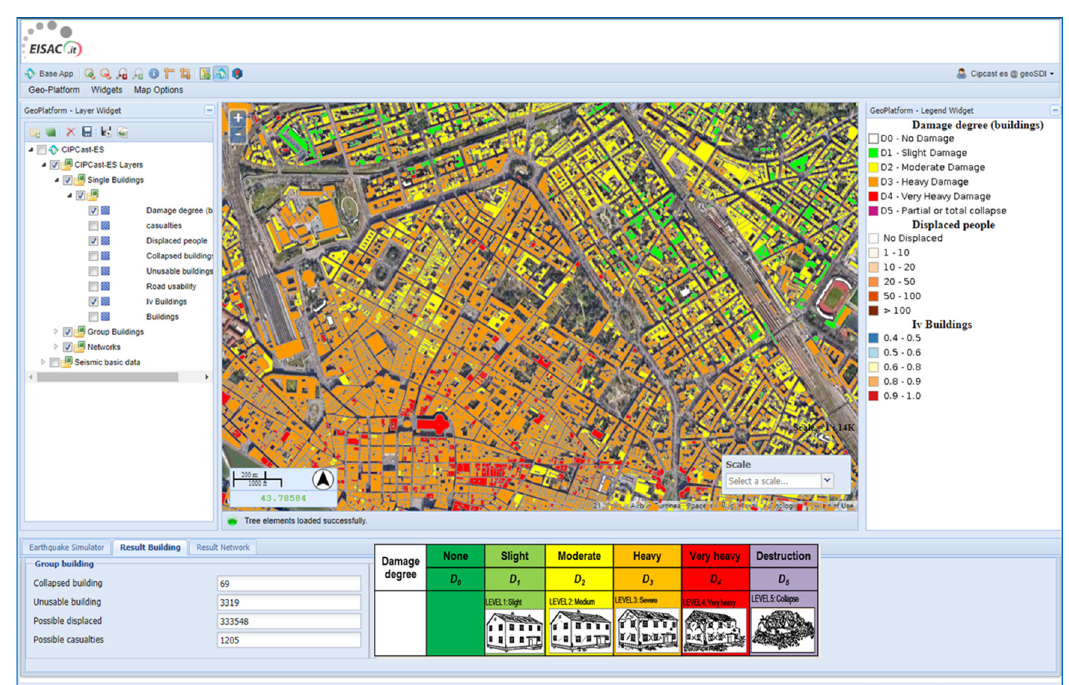
Figure 2. Assessment and representation of earthquake-induced physical damage in ARCH DSS.